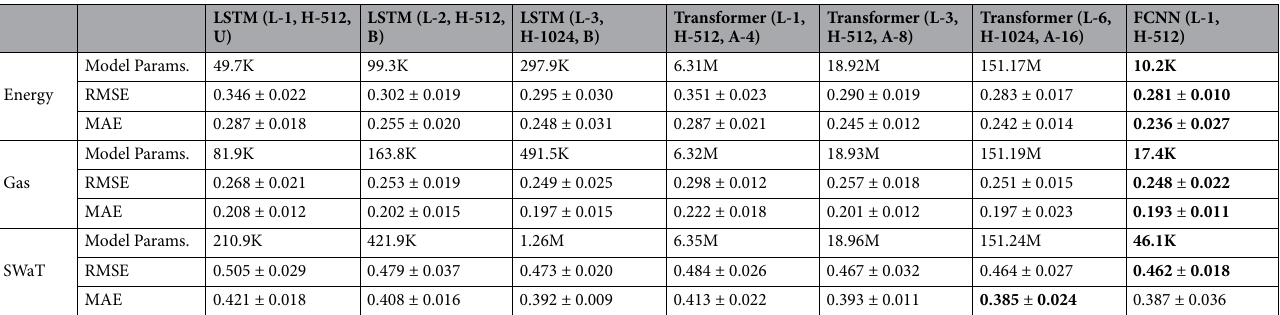
Table 4. Comparison of DNN-based models for DINI. MPAR corruption was considered since it is the hardest to model in time-series datasets. ‘L’: number of layers (stacks in LSTM, hidden layers in FCNN), ‘H’: hidden dimension (number of neurons in the hidden layer for the FCNN), ‘U/B’: uni-/bi-directional model, ‘A’: number of attention heads in the Transformer. Values corresponding to the lowest number of model parameters or error are in